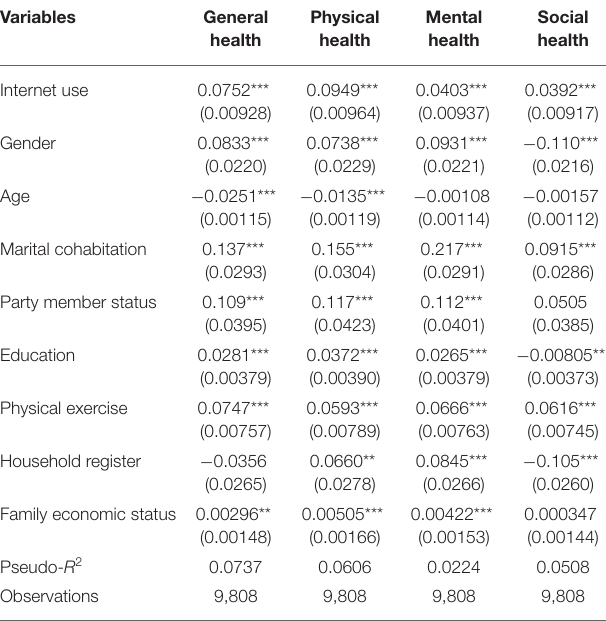
Figure 1 . With the increase in Internet use time, the degree